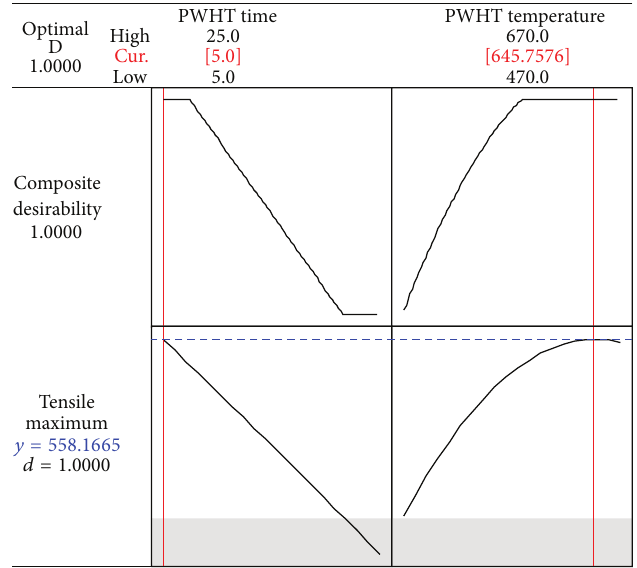
Figure 4: Response optimization of tensile strength.